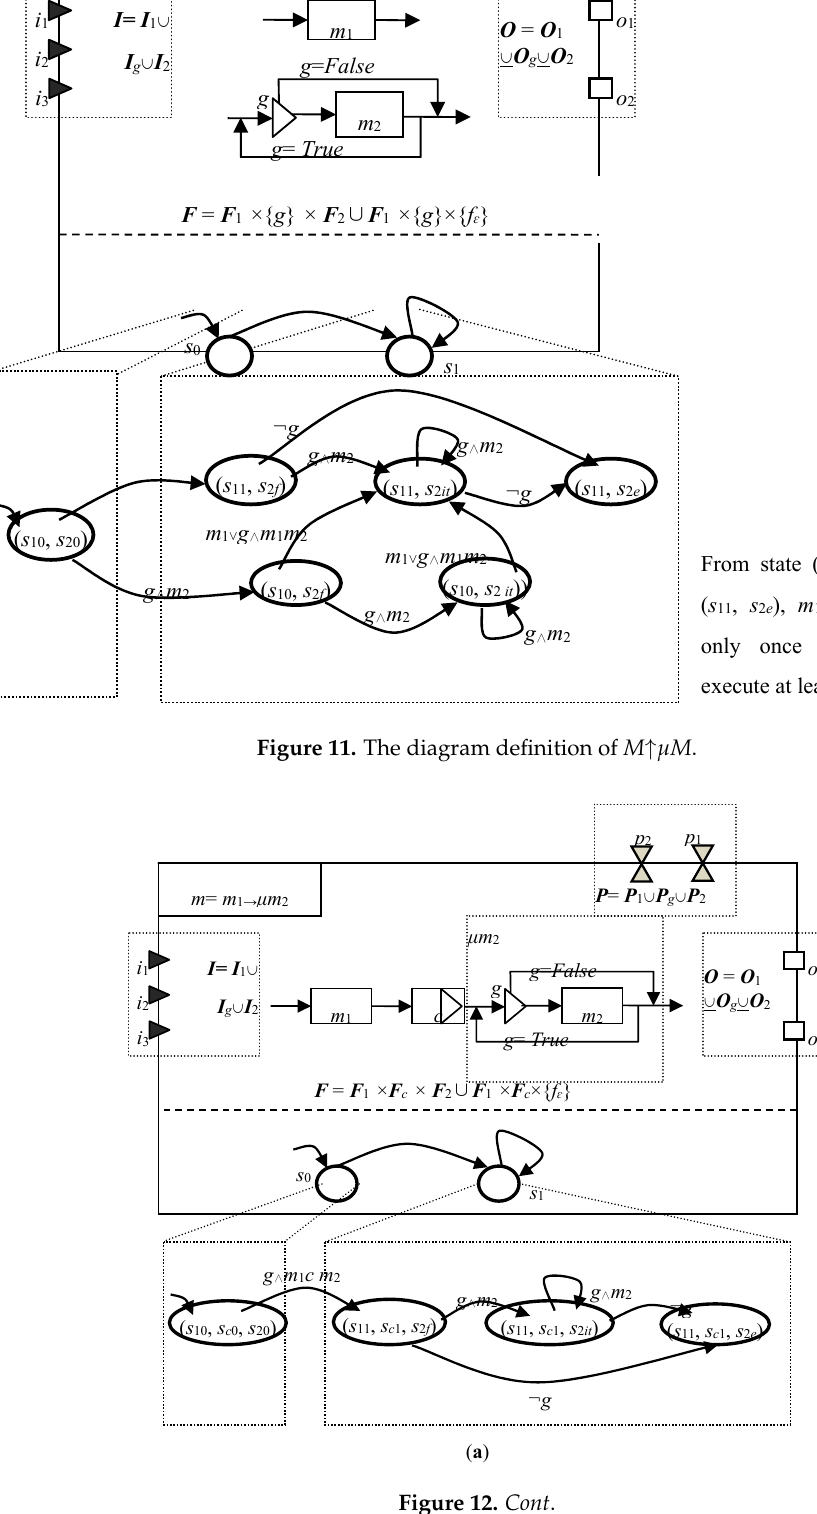
Figure 12. The diagram definition of M → μ M . ( a ) M → Μ m; ( b ) μ M → M.